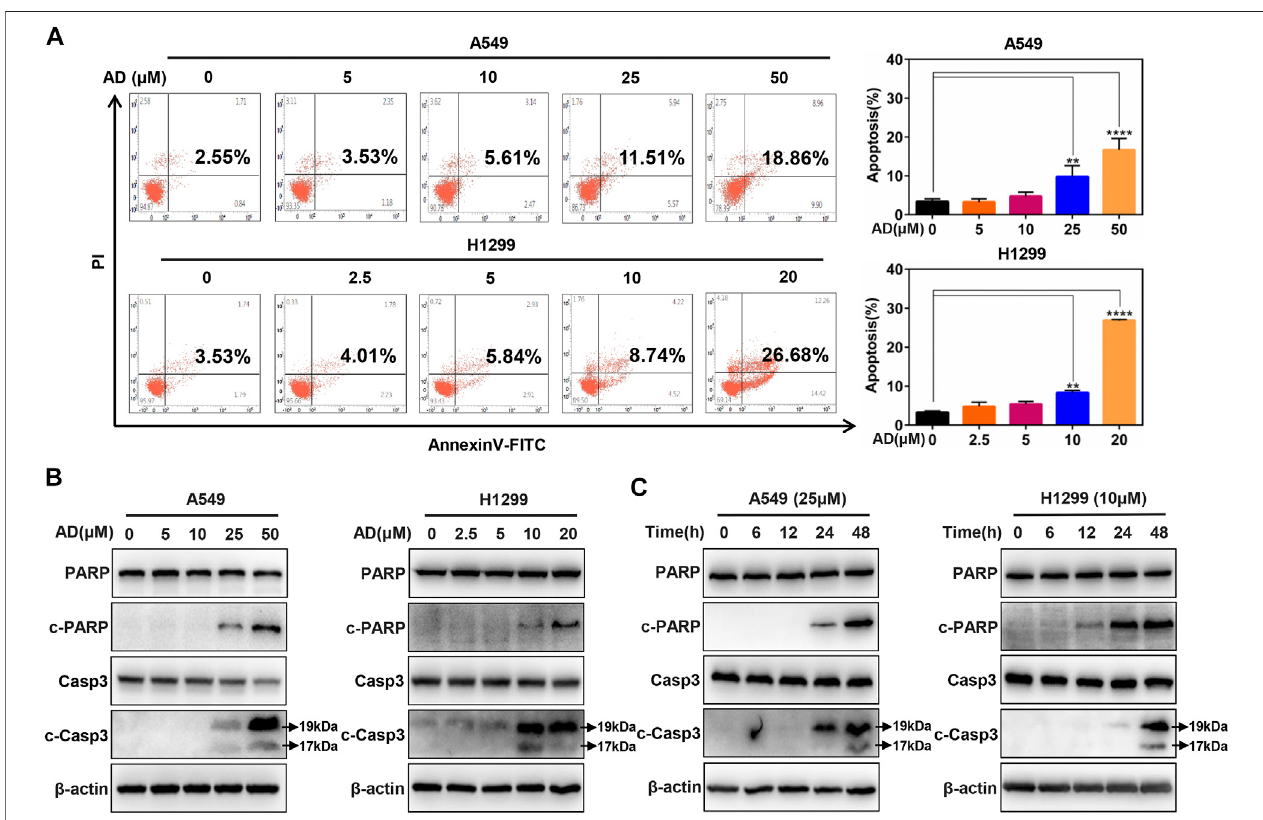
FIGURE2| Andrographolidetriggeredapoptosisinhumanlungadenocarcinomacells (A) Cellsweretreatedwith1 ‰ DMSOorindicatedconcentrationsofADfor 24 h,thensubjectedtoAnnexinV-FITC/PIstaining,followedbythe fl owcytometricanalysis. (B – C) Afterbeingtreatedwith1 ‰ DMSOorADatindicatedconcentrations and different times, cell protein was extracted and detected by Western blotting with antibodies against PARP, c-PARP, Casp3 and c-Casp3, and β -actin (** p ≤ 0.01; **** p ≤ 0.0001).